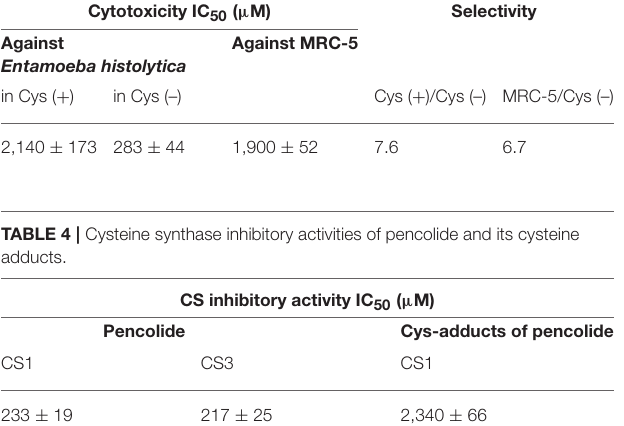
TABLE 3 | In vitro antiamebic activities and cytotoxicity against MRC-5 cells of pencolide. Cytotoxicity IC 50 ( µ M)